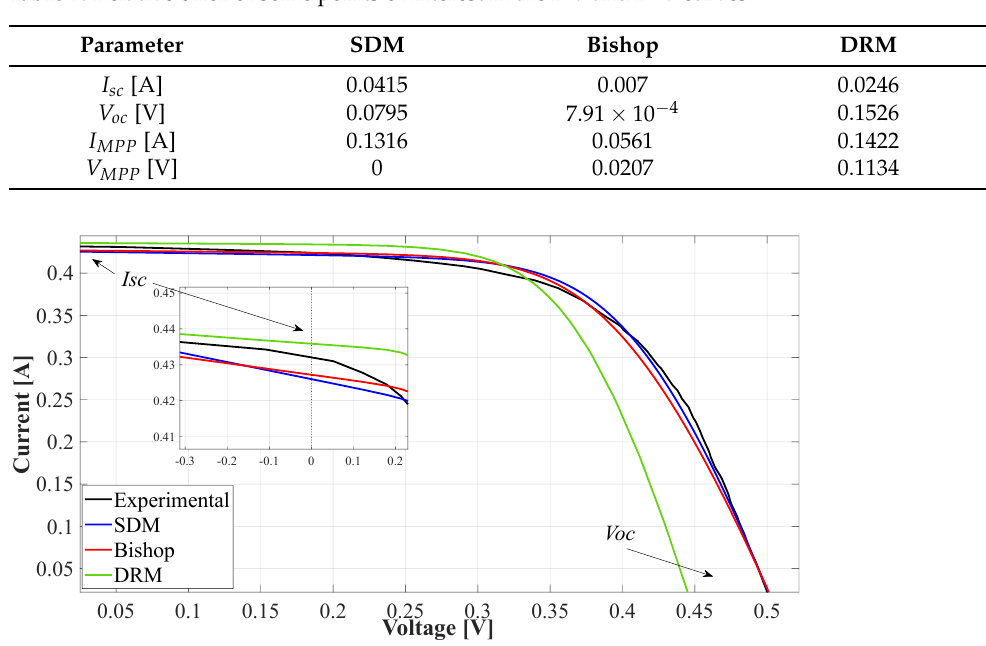
Figure 7. Comparison between the experimental and estimated curves in Q 1 and Q 2 (zoom-in for Q 2 ). Table 7. Relative error of some points of interest in the I–V and P–V curves.